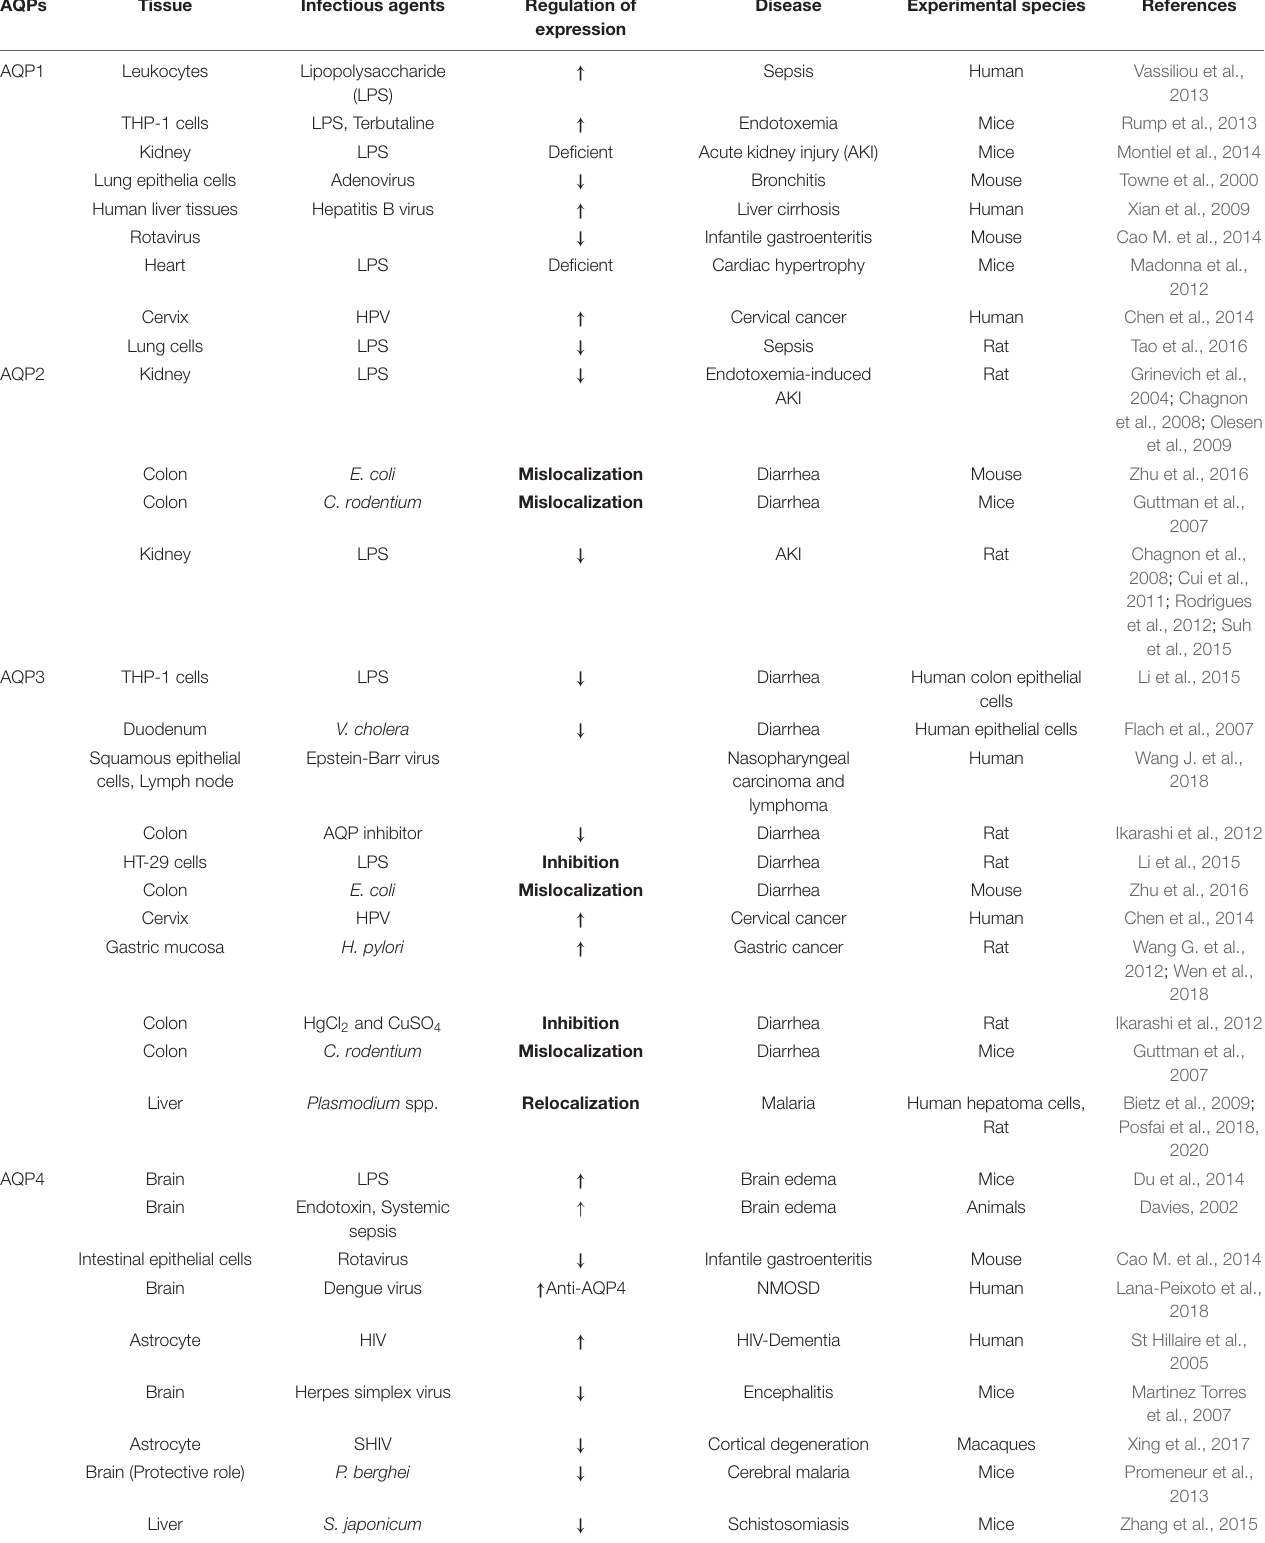
TABLE 2 | Regulation of expression of AQPs during infectious